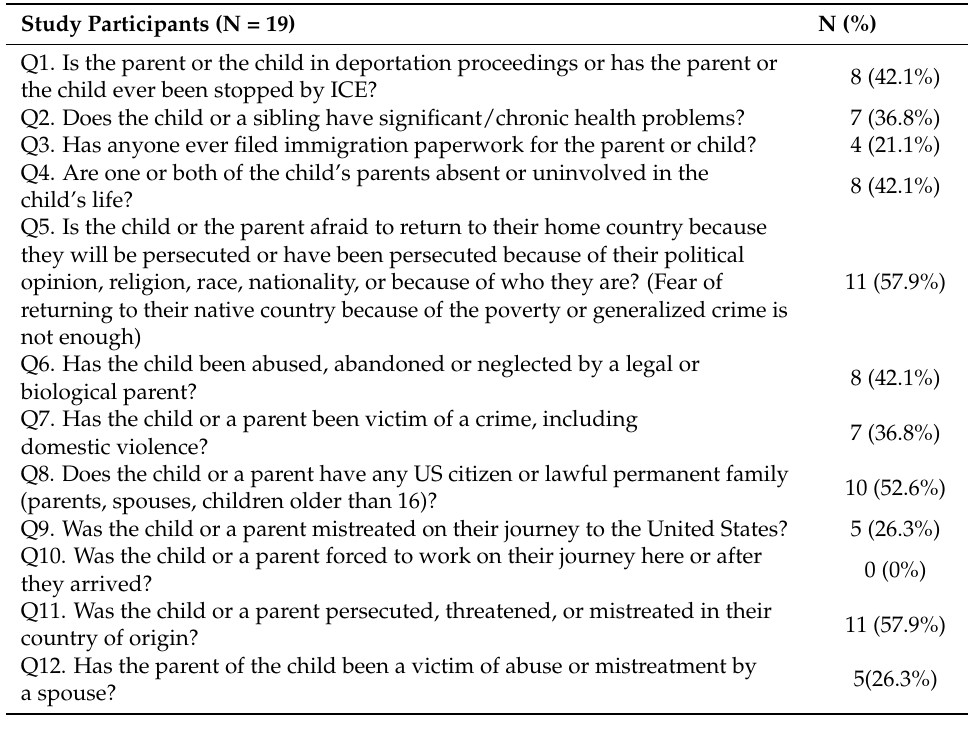
Table 3. Legal Needs Screening Tool